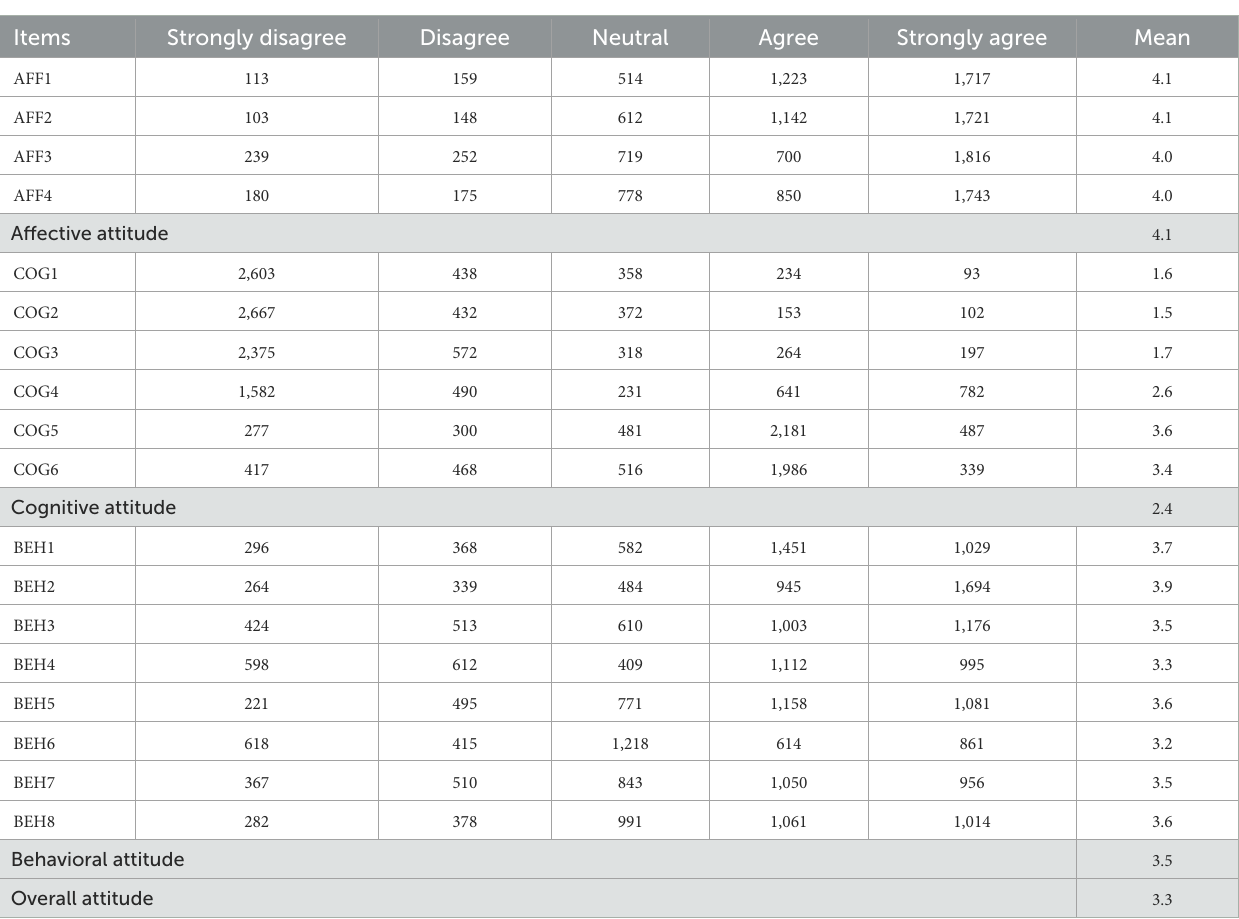
TABLE 4 Descriptive statistics for scale